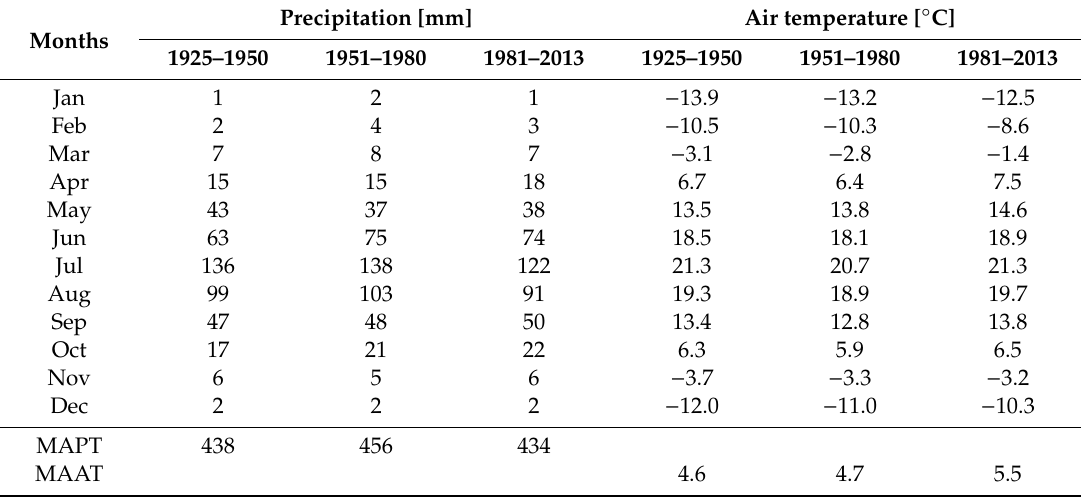
Table 1. Mean monthly precipitation sum, mean monthly air temperature, mean annual precipitation totals (MAPT) and mean annual air temperature (MAAT) at the meteorological station of Weichang County, Hebei province, 2013. The monitoring period is split into the sub-periods 1925–1950, 1951–1980 and